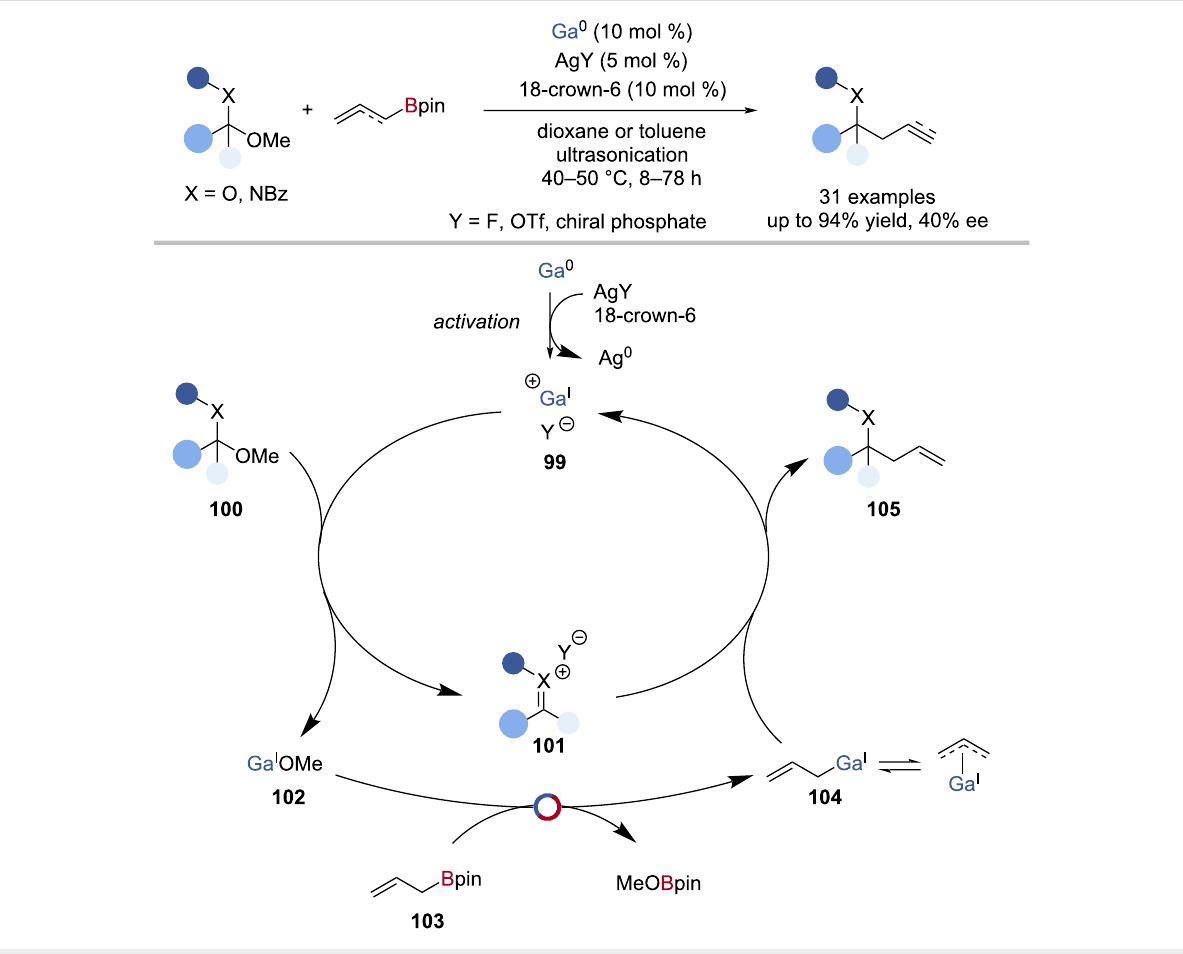
Scheme 25: Gallium(I)-catalysed allylation/propargylation of acetals and aminals and the proposed